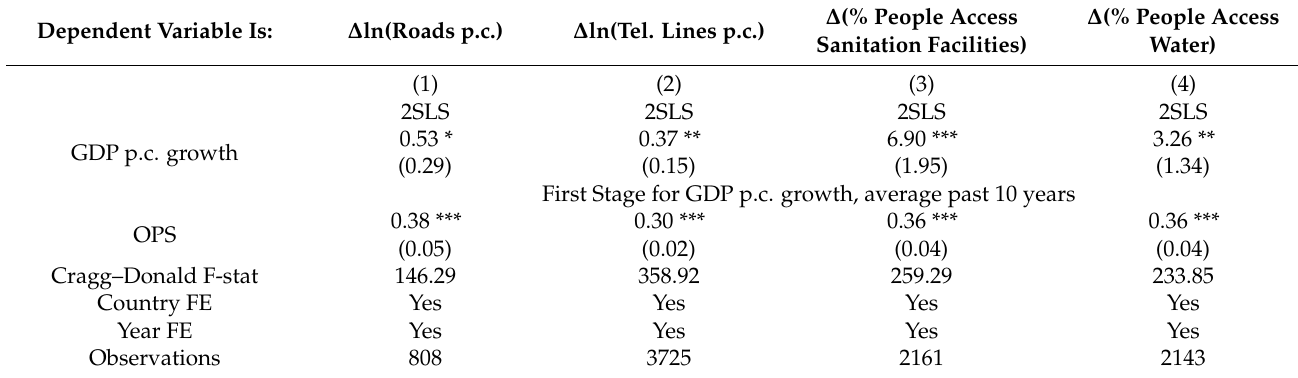
Table 3. GDP growth and infrastructure (2SLS